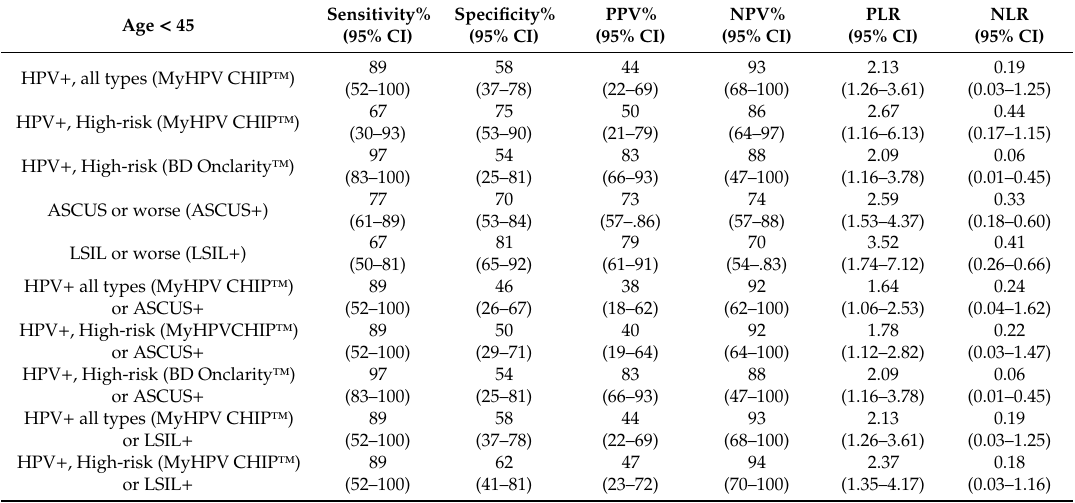
Table 13. Performance of HPV test combinations and cytology for the detection of CIN2 or worse (Age <45).